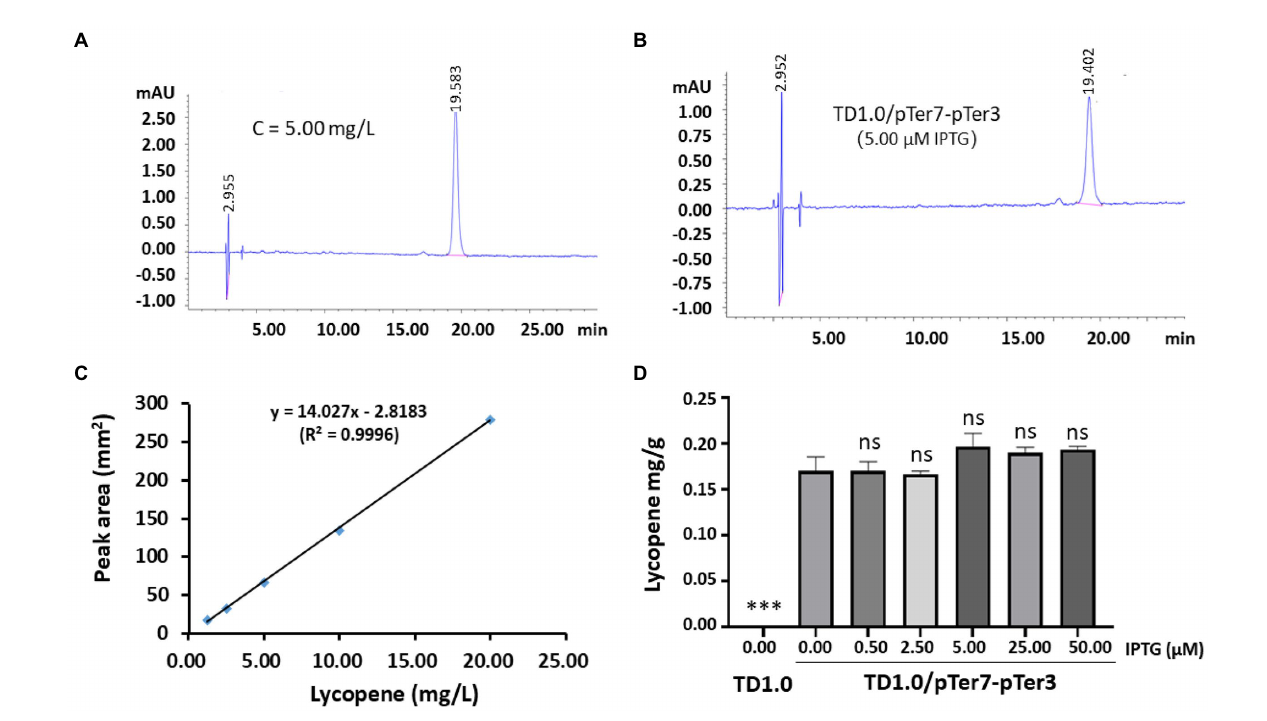
FIGURE 2 Production and characterization of lycopene in TD1.0/pTer7-pTer3 induced with different concentrations of IPTG. (A) The representative HPLC spectrum of the standard lycopene. A concentration of 5.00 mg/L lycopene was prepared, and the sample was detected by HPLC. The peak appeared at 20 min of elution. (B) The representative HPLC spectrum of the lycopene produced by TD1.0/pTer7-pTer3 after the induction of 5.00 μ M IPTG. (C) Standard curve of lycopene. The lycopene standard was prepared and diluted with acetone for five concentration gradients (1.25, 2.50, 5.00, 10.00, and 20.00 mg/L). HPLC analysis was performed, and the peak areas were calculated for each concentration of lycopene. The curve was drawn using lycopene concentration against the relative peak areas. (D) Lycopene production in TD1.0/pTer7-pTer3 after induction with different concentrations of IPTG. H. bluephagenesis TD1.0/pTer7-pTer3 was cultured in a minimal medium supplemented with 30 g/L glucose as carbon source (60-MMG medium). For lycopene production, diverse concentrations of IPTG (0.00, 0.50, 2.50, 5.00, 25.00, and 50.00 μ M) were added ( n = 3 per concentration). All samples were obtained after 48 h cultivation at 37 ° C with shaking. Bacterial cells were harvested after culture, lysed, and subjected to HPLC analysis. The lycopene yield was calculated according to the standard curve and presented as milligrams per gram of DCW. The data were presented as mean ± standard derivation (SD). Statistical significances were calculated by one-way ANOVA and compared with TD1.0/pTer7-pTer3 without IPTG induction (0.00 IPTG). ns indicates no statistical significance; *** p <